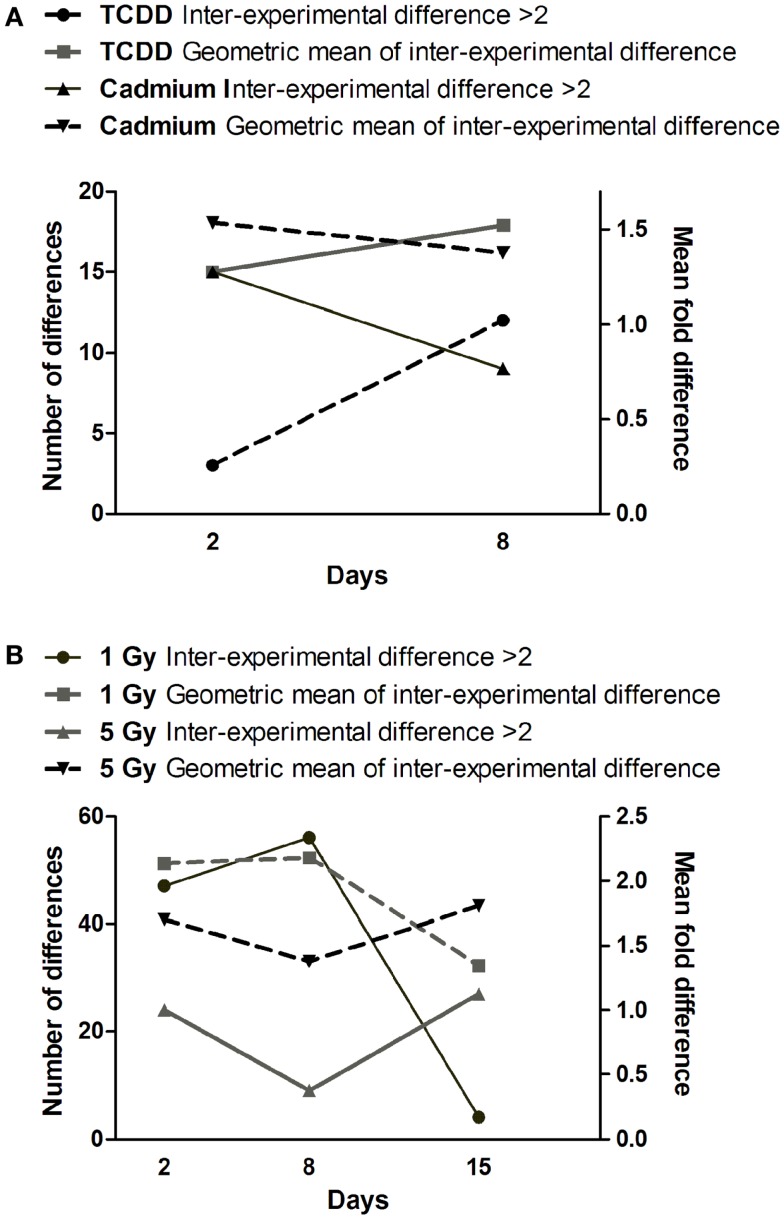
Time dependence of miRNA expression differences in cells exposed to (A) cadmium or TCDD or (B) radiation. The left y-axis is for the number of differences (≥twofold) between the two experiments (inter-experimental difference). The right y-axis is for geometric mean of fold differences between the two experiments.